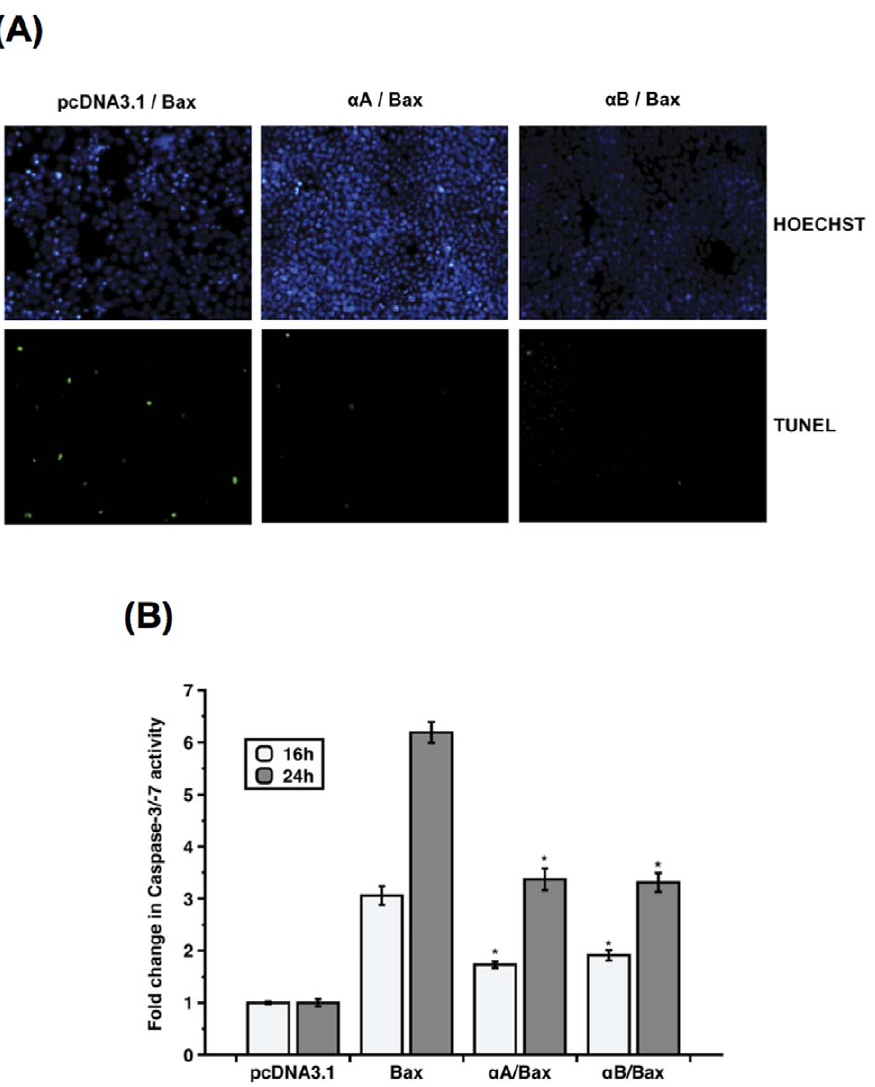
Figure 3. Anti-apoptotic activity of a -crystallins against Bax-induced apoptosis. 293T cells were transiently co-transfected with pcDNA3- Bax and with either the empty pcDNA3.1, pcDNA3.1- a A- ( a A) or pcDNA3.1- a B ( a B)-crystallin constructs. ( A ) TUNEL assay showing that Bax-triggered apoptosis was inhibited in 293T cells overexpressing the a -crystallins, as reflected by the reduced number of TUNEL-positive apoptotic cells. Cell nuclei were counterstained with Hoechst. ( B ) As assessed by luminescent caspase assay, Bax-induced Caspase-3/-7 activity was inhibited in the presence of a A- ( a A) and a B- ( a B) crystallins 16 h and 24 h post-transfection. (* p , 0.0001 by t -test for Bax versus a A/Bax and for Bax versus a B/Bax at 16 h and 24 h). Data are the mean 6 SE of three independent experiments, each performed in